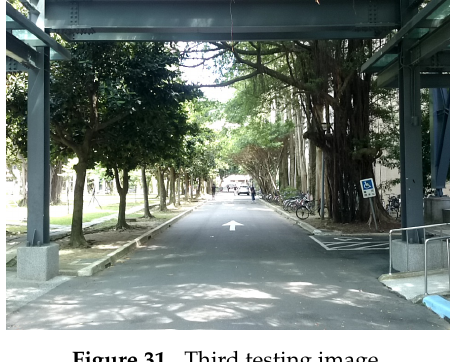
Figure 31. Third testing image. Table 5. The score for each composition method in the third testing image.